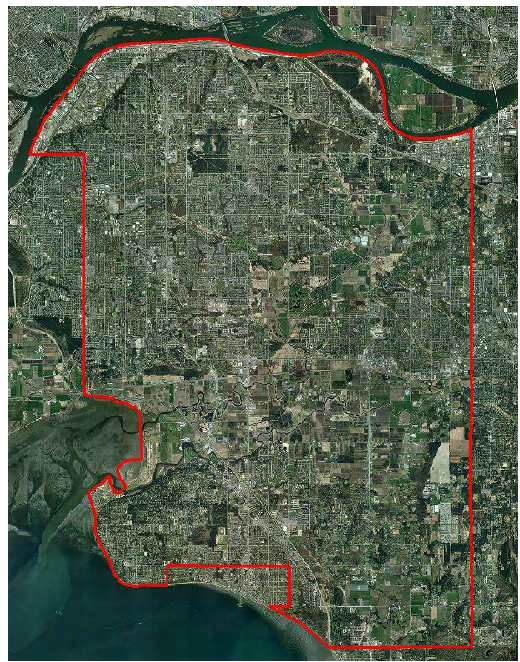
Figure 1. Study area – Data collection coverage